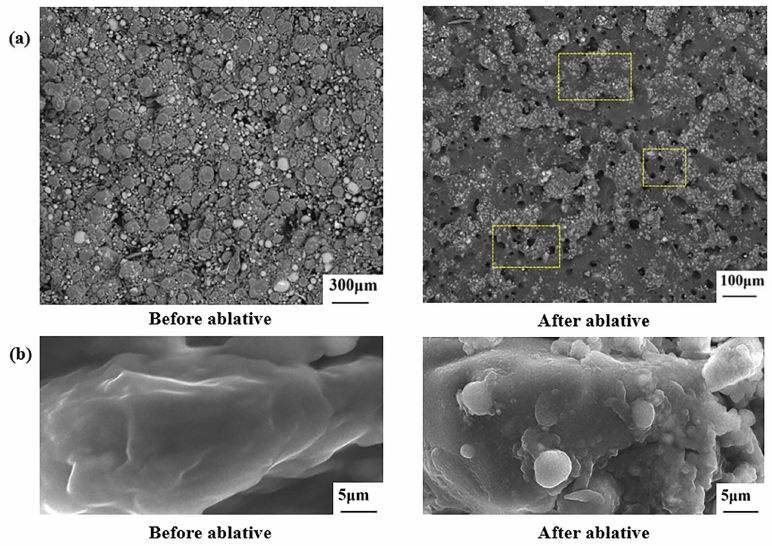
Figure 12. Microscopic appearance. ( a ): the inner wall surface of the motor before and after ablation, ( b ): PA12 before and after ablation.